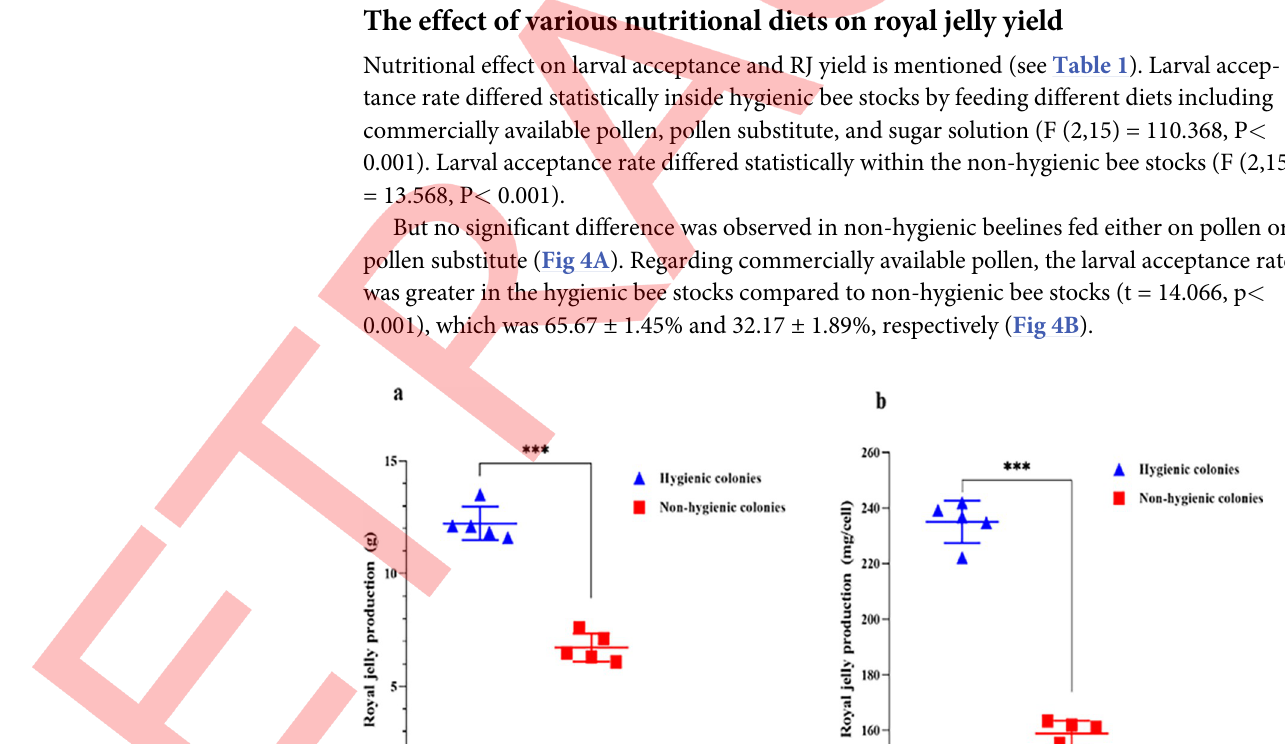
Fig 3. The mean weight (shows as mean ± SE) of Royal Jelly (RJ) collection between hygienic and non-hygienic around 72 h after larval grafting. (a) RJ yield in grams/ colony after 72 h harvesting. (b) RJ yield mg/ cell cup between both bee